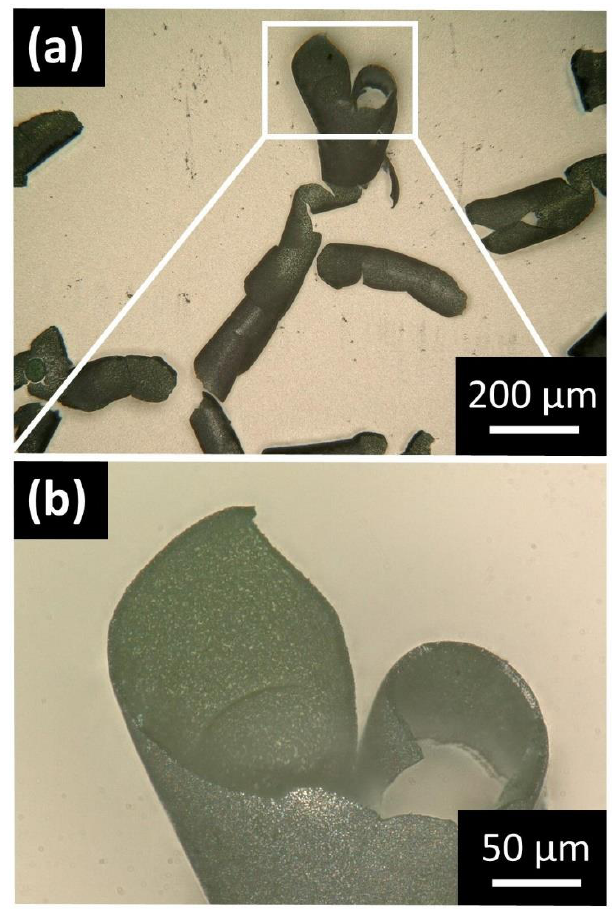
Figure 2. Digital light microscopy (DLM) images of Co(OH) 2 /PSS microscrolls. ( a ) Overview of curled fragments of the solid mineral film. Due to the lateral homogeneity of the film and the irregular fragmentation, the direction and exact pattern of self-rolling is unspecific. ( b ) Cross-section of an individual microscroll formed from a film fragment with an estimated mean thickness of 6.59 ± 0.27 µm.